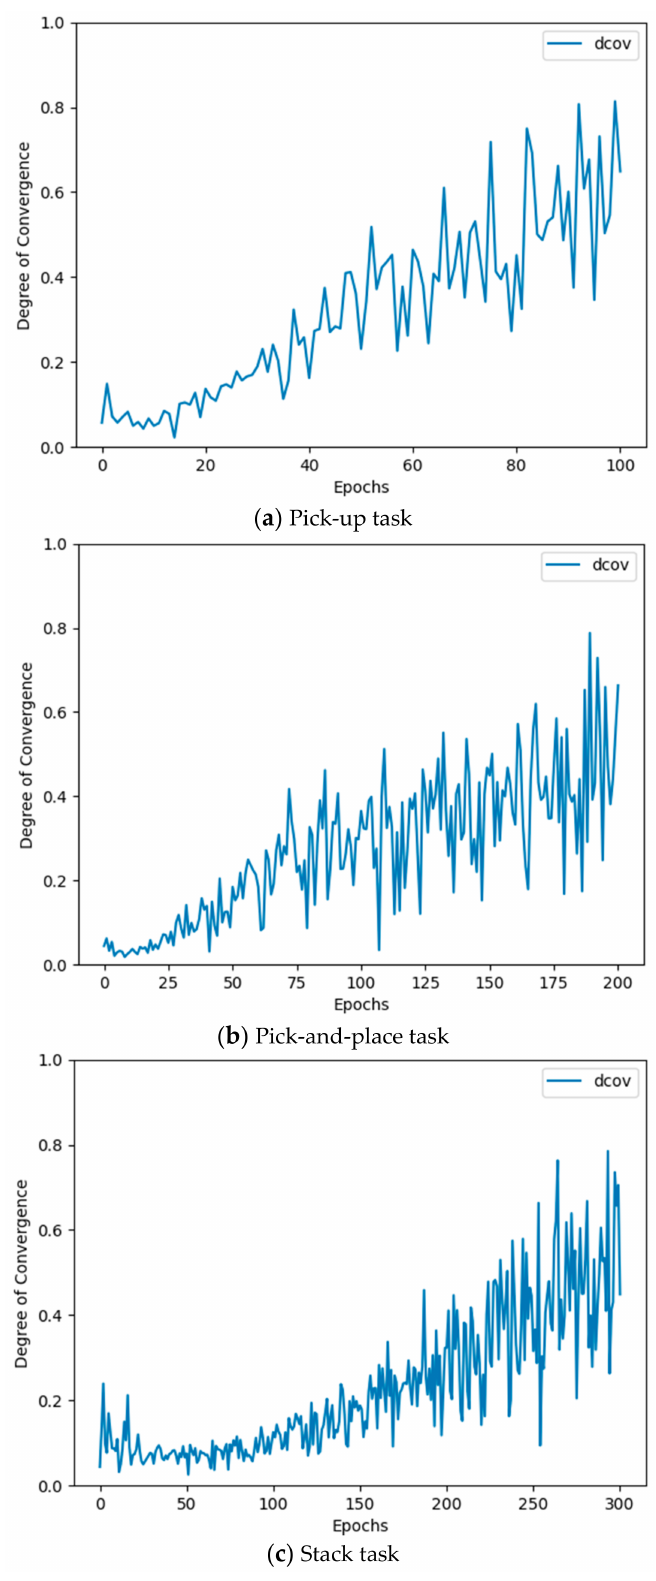
Figure 6. Changes in d conv for learning manipulation